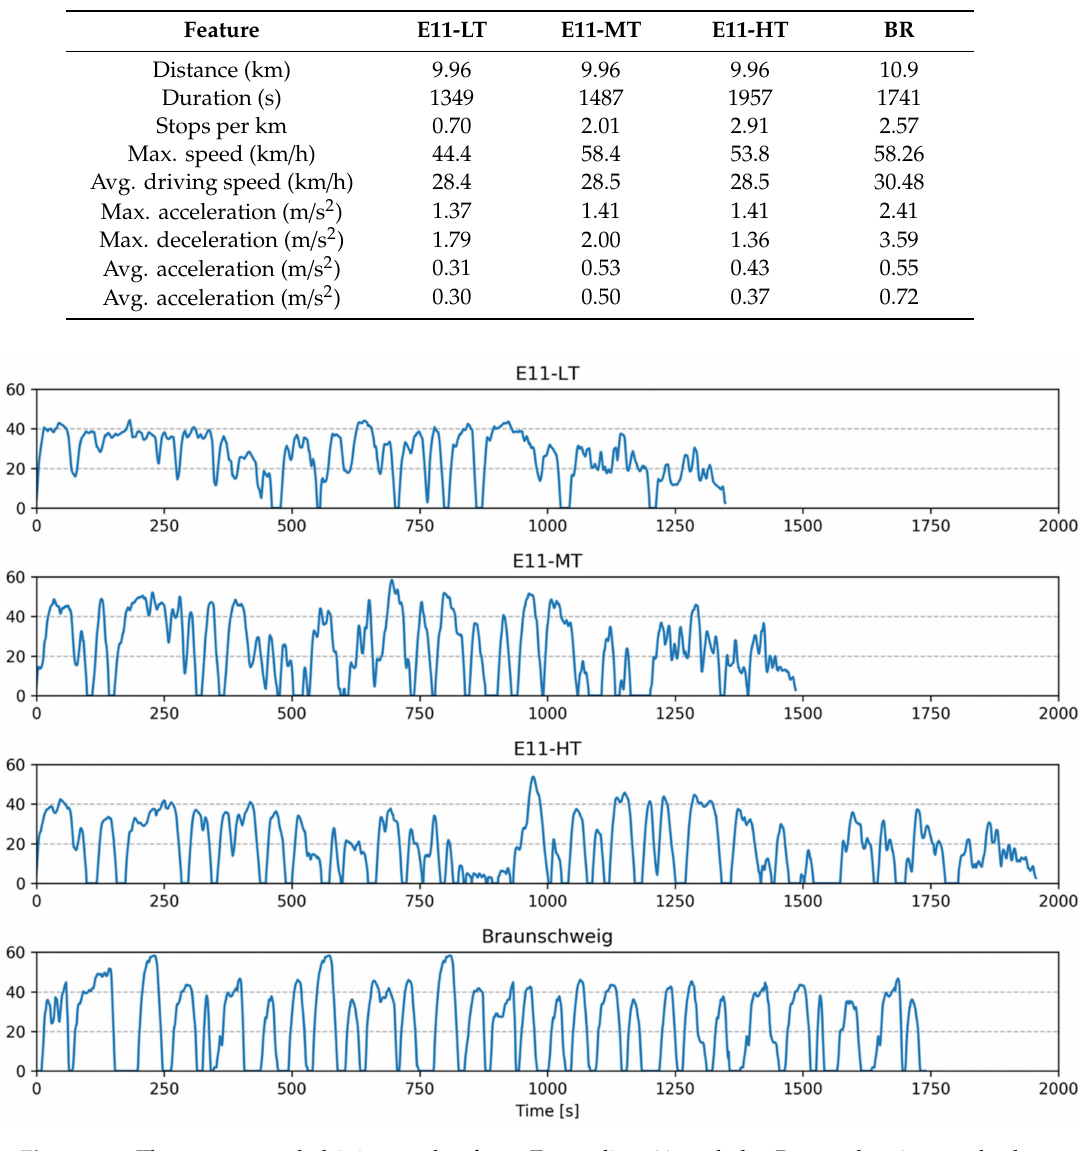
Figure 7. Three measured driving cycles from Espoo line 11 and the Braunschweig standard reference